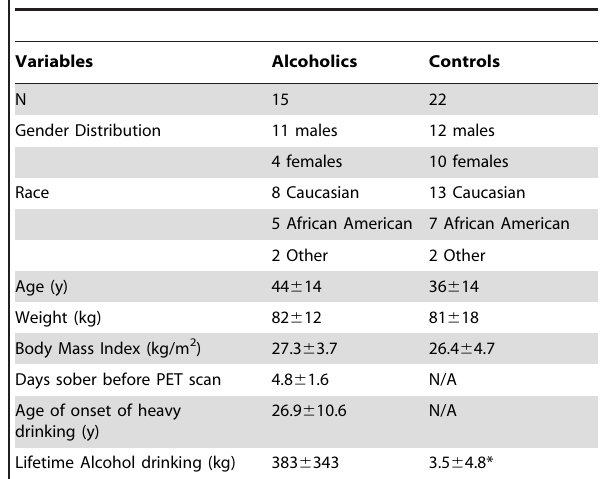
Table 1. Descriptive variables.